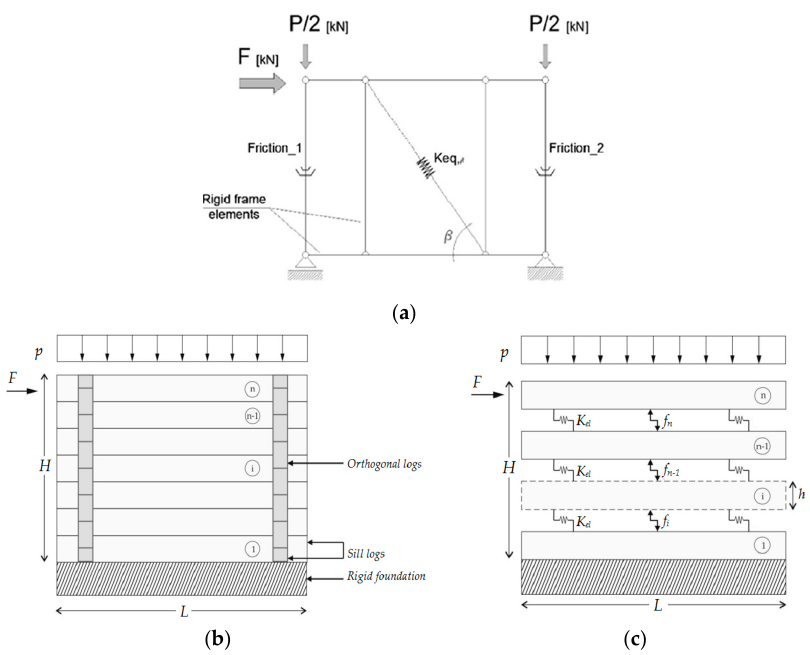
Figure 9. ( a ) A simplified numerical model for simulation of log house buildings based on the nonlinear spring approach [51]. ( b ) Full-scale assembly of a log house shear wall. ( c ) A simplified analytical model including different springs [55] ( F : lateral load, p : vertical load, H : height, L : length, k eq : equivalent stiffness of the corner joints, k el : equivalent stiffness, f i : Coulomb forces, h : timber log’s